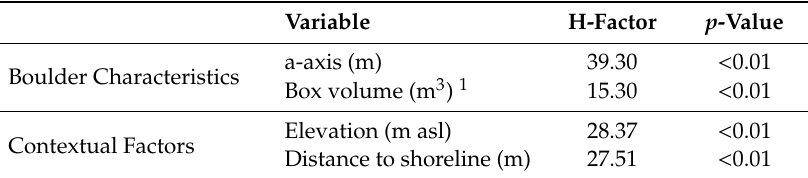
Table A2. Kruskal–Wallis 3-way di ff erence test between boulder